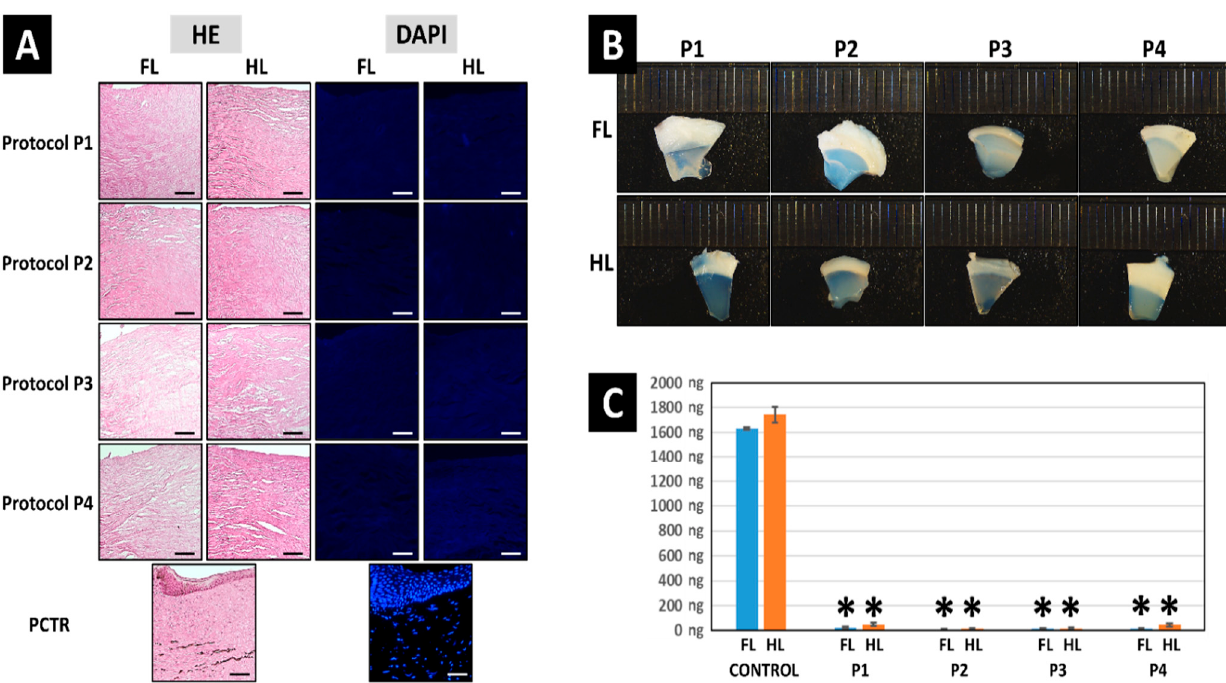
Figure 2. Analysis of native porcine limbus (PCTR) and decellularized limbi using four different decellularization methods (P1 to P4). Each decellularization protocol was applied to the full-thickness limbus (FL) and the half-thickness limbus (HL). ( A ) Histological analysis using hematoxylin-eosin (HE) and DAPI. ( B ) Macroscopical images showing transparency levels of each DL on a black scale in millimeters. ( C ) Quantification of residual DNA (in ng of DNA per mg of dry weight of tissue) in controls and DL. Asterisks (*) represent statistically significant differences with both the FL and the HL controls ( p < 0.05). Nonsignificant differences were found among the different samples decellularized with P1, P2, P3, and P4. Scale bars: 50 μ m.